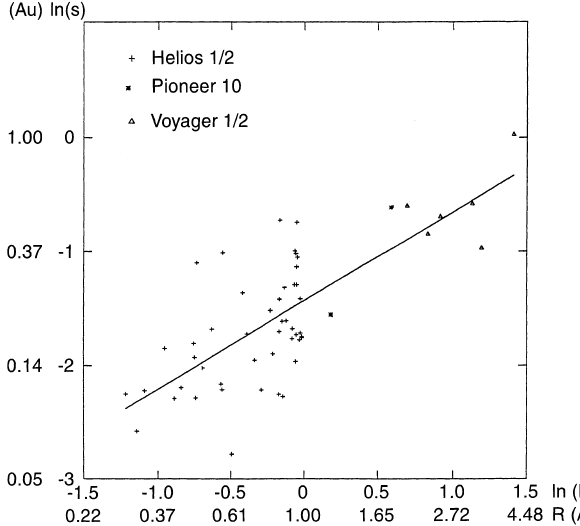
Fig. 14. Double logarithmic plot showing the radial sizes, s , of MCs observed by Helios 1/2 (+), Voyager 1/2 ( (cid:68) ), Pioneer 10 (*) between 0.3 and 4.2 AU, versus solar distance, R (from Bothmer and Schwenn, 1994). The straight line was obtained by linear regression: s (cid:133) R (cid:134) (cid:136) (cid:133) 0 : 24 (cid:6) 0 : 01 (cid:134) (cid:2) R 0 : 78 (cid:6) 0 : 10 [AU]